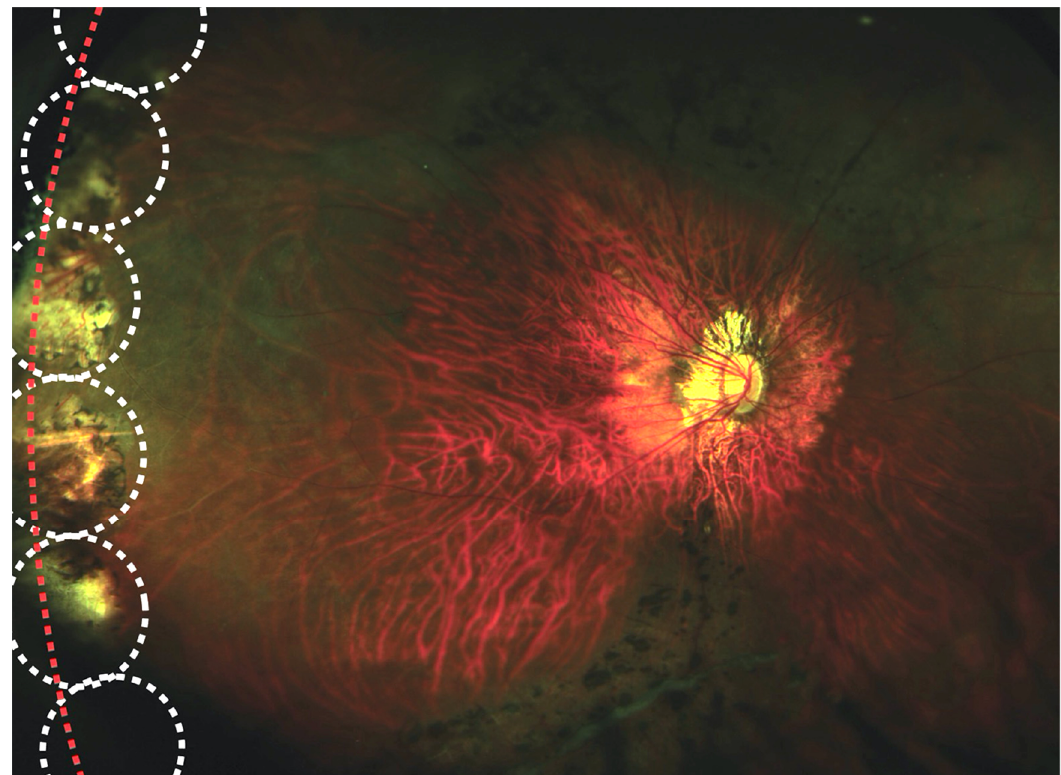
Figure 1. Prophylactic 360-degree cryoretinopexy in Type 1 Stickler syndrome according to Cam- bridge Prophylactic Cryotherapy Protocol. White circles show locations of individual cryotherapy applications, which are contiguous with one another and include the ora serrata (red line).